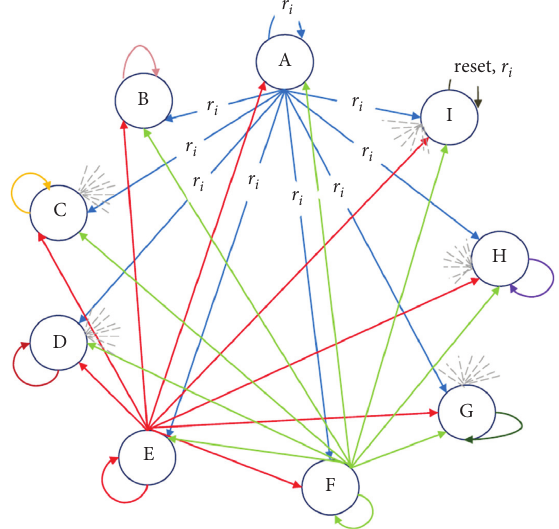
Figure 13: Extended state chain diagram ( r